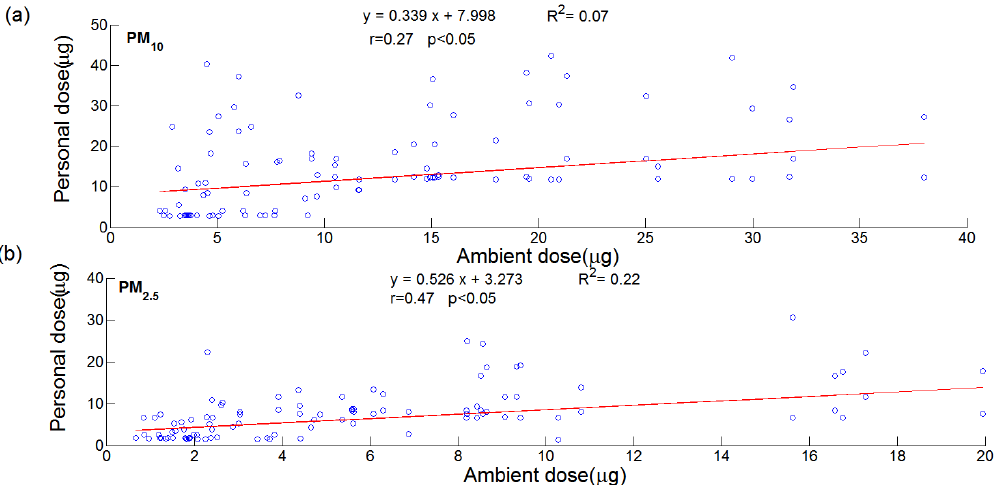
Figure 4. Linear regression between hourly ambient (outdoor exposure scenario) and personal (re- alistic exposure scenario) dose ( μ g) for ( a ) PM 10 and ( b ) PM 2.5